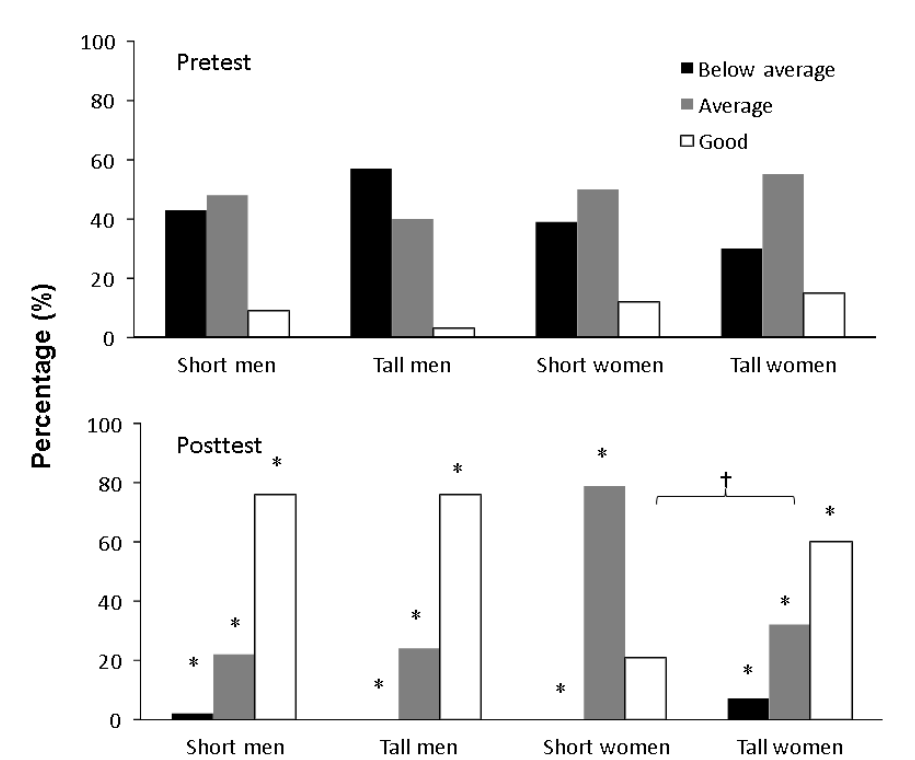
Figur 1. Assumptions about own abilities for conflict resolution with physical skills by short (N = 44) and tall (N = 39) men, short (N = 26) and tall (N = 27) women at pre-test and post-test. † indicates significantly difference between short and tall women at post-test on 0.05 level. * Indicates significantly different from pre-test to post test at 0.05